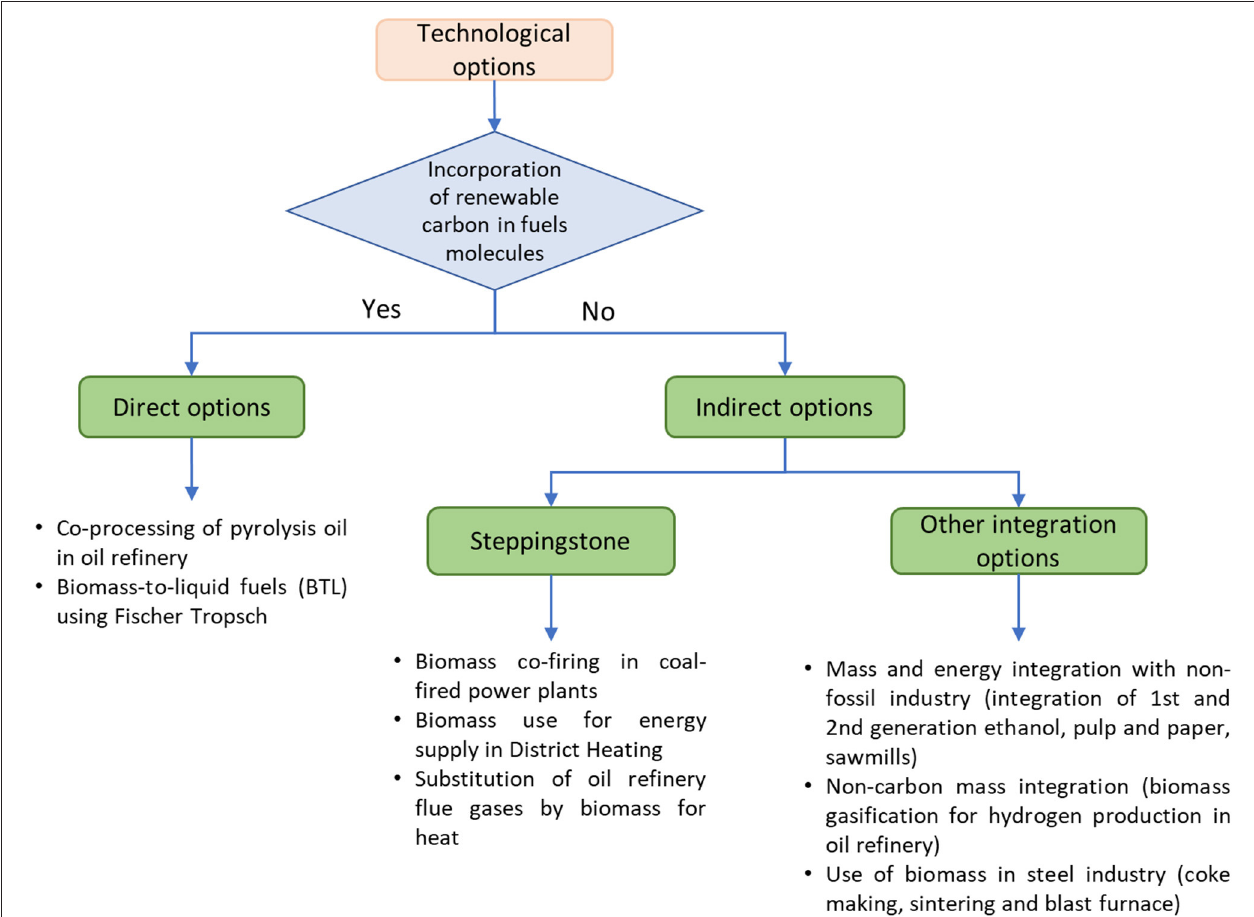
FIGURE 1 | Technological options which can facilitate biomass use toward greener fossil fuel